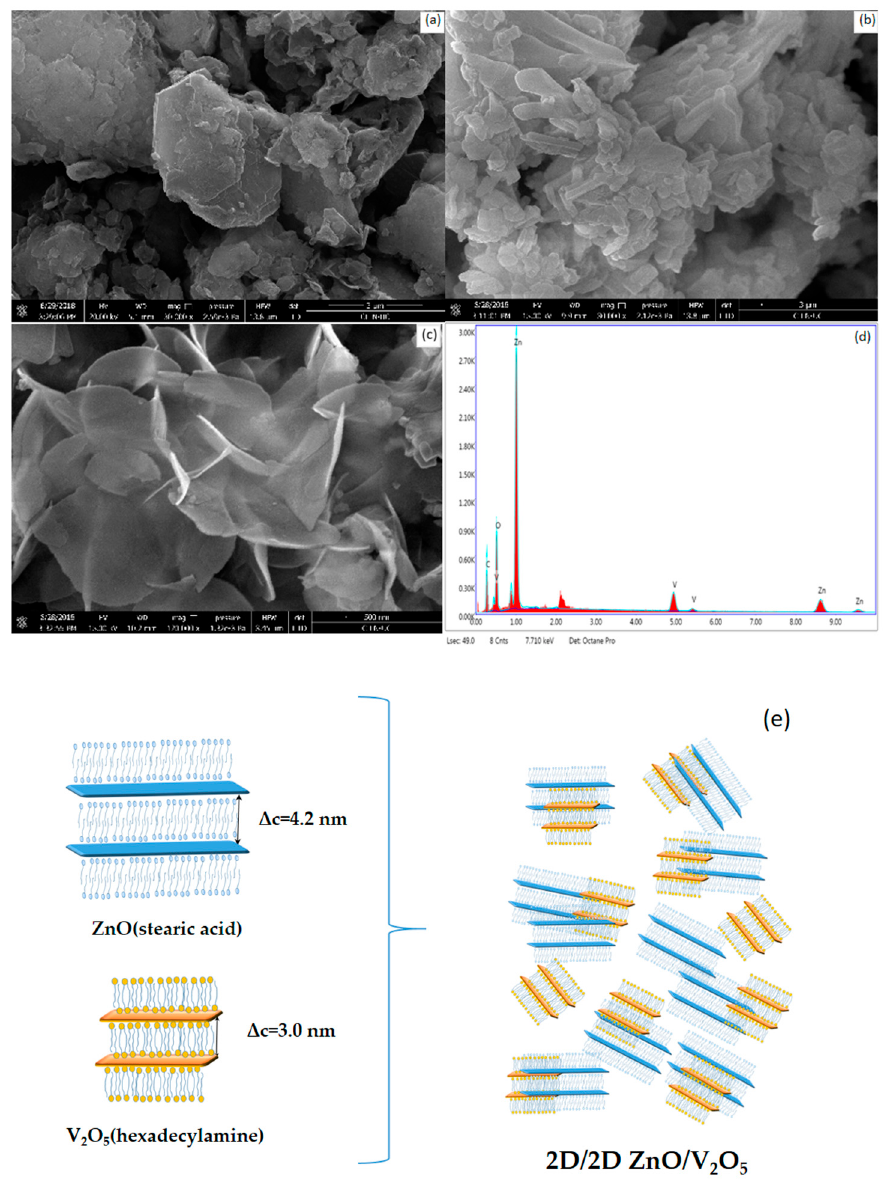
Figure 3. ( a ) SEM micrographs ZnO(SA); ( b ) SEM micrographs V 2 O 5 (HDA); ( c ) SEM micrographs ZnO(SA)/V 2 O 5 (HDA); ( d ) EDX pattern and ( e ) Schematic representation 2D/2D heterojunction.